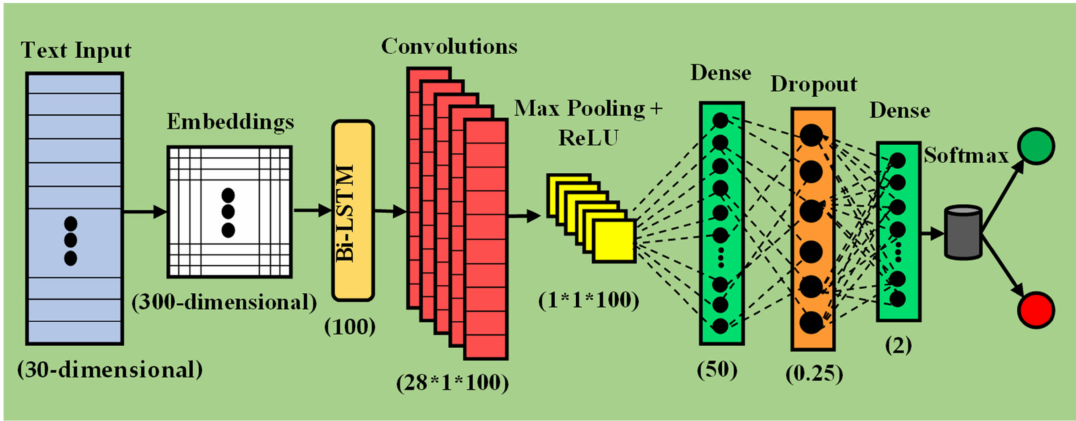
Figure 4. Architectural representation of CNN-BiLSTM framework.